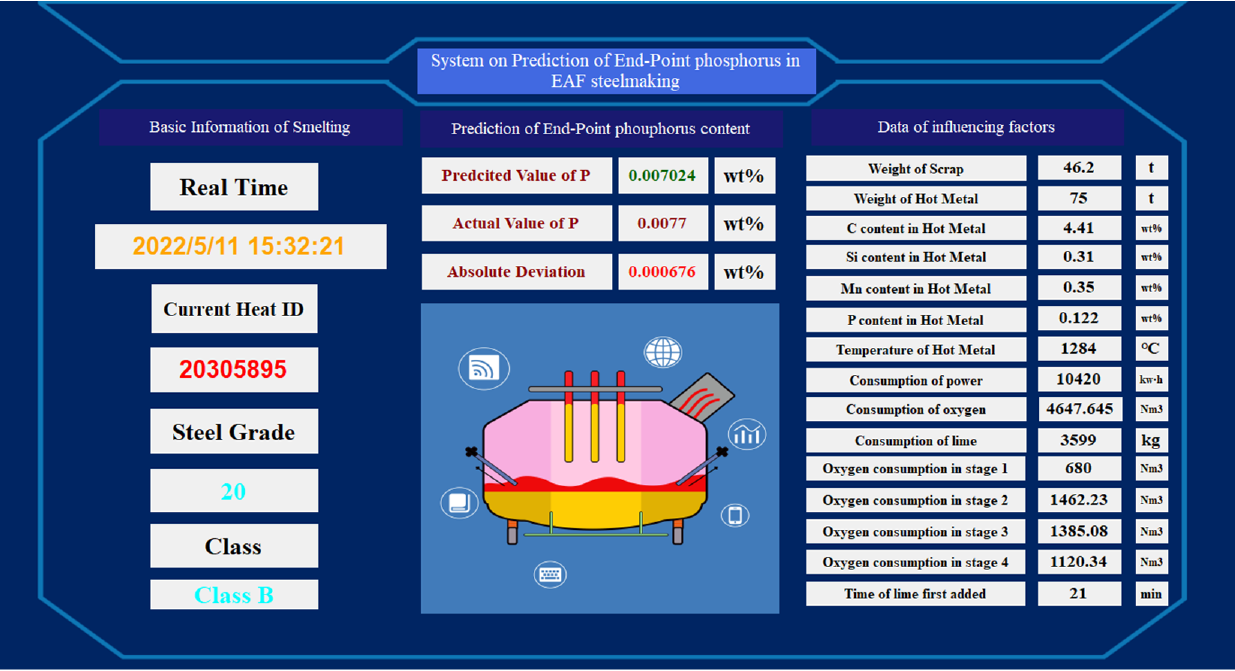
Table 6. Results for prediction system of end-point P